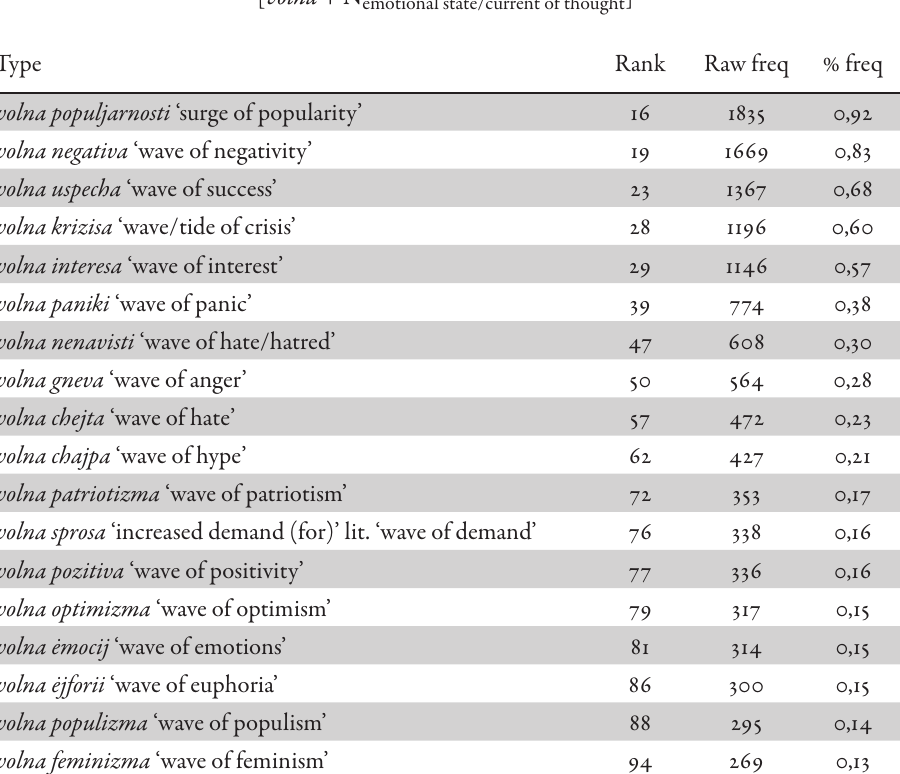
[ volna + N emotional state/current of thought